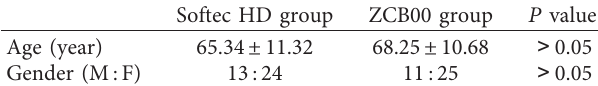
Table 1: The age and gender